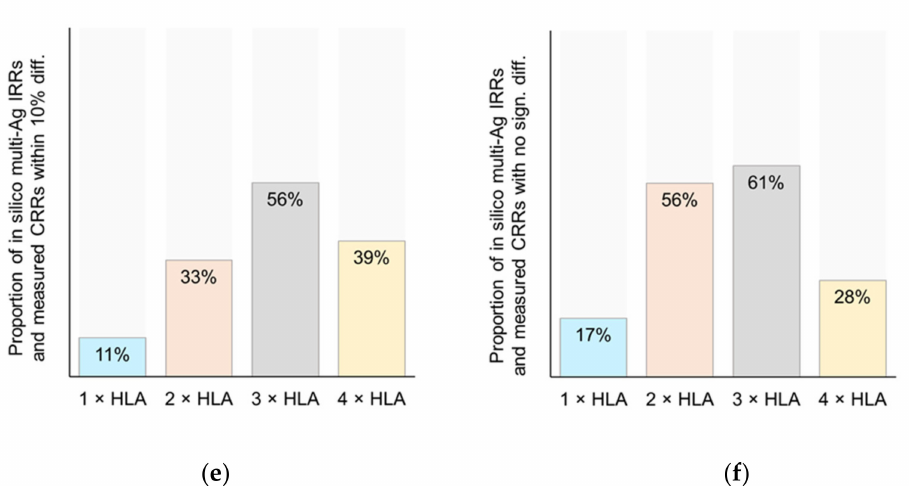
Figure 6. Correlation between CRRs measured by CTs and in silico multi-Ag IRRs. Analysis included 23 CTs with 16 vaccines, total of 18 data points. Prediction of multi-Ag IRRs is based on the frequency of subjects in the MP with at least two vaccine-specific epitopes originated from different protein antigens that are ( a ) restricted to ≥ 1 autologous HLA class I allele ( r = 0.2865, p = 0.2491), ( b ) restricted to ≥ 2 autologous HLA class I alleles ( r = 0.5355, p = 0.0220), ( c ) restricted to ≥ 3 autologous HLA class I alleles ( r = 0.6709, p = 0.0023), ( d ) restricted to ≥ 4 autologous HLA class I alleles ( r = 0.7116, p = 0.0009). Orange dashed line: perpendicular trend line with 95% confidence interval band (95% prediction interval band is shown by thicker dashed line). ( e , f ) Pairwise analysis of measured CRRs and predicted multi-Ag IRRs. Bars represent the proportion of the analyzed data pairs where difference was ( e ) within 10%, ( f ) not significant ( p >